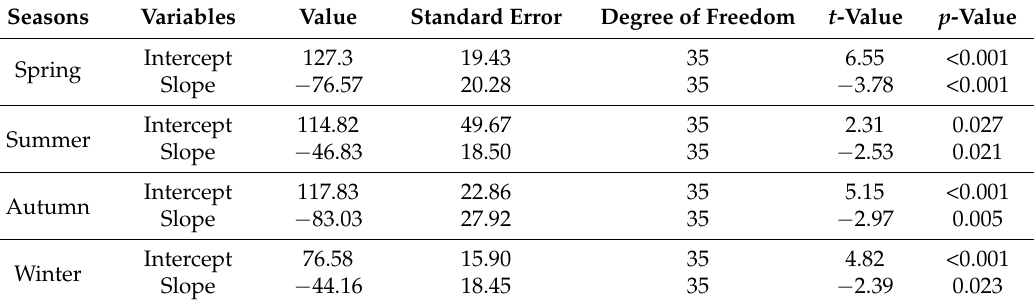
Table 2. Linear Mixed Effects Model analyses for the relationship between phytoplankton evenness and copepod abundance in different